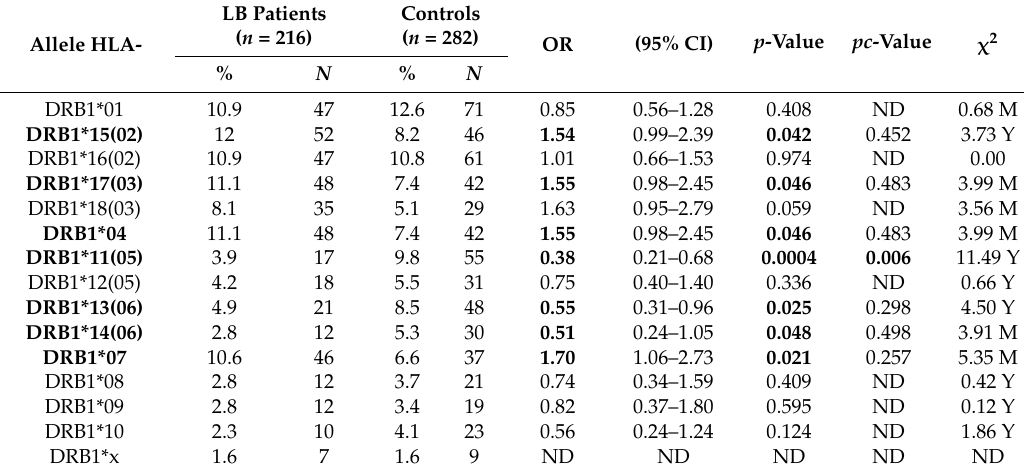
Table 3. The frequency of DRB1* alleles studied in-patients with Lyme borreliosis and healthy controls from Latvia.